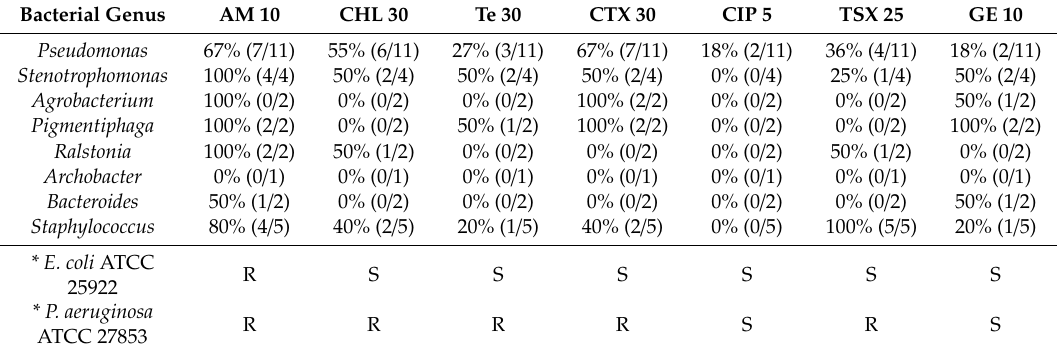
Table 3. Antimicrobial susceptibility of bacterial genus isolated from both haemodialysis centres. Bacterial Genus AM